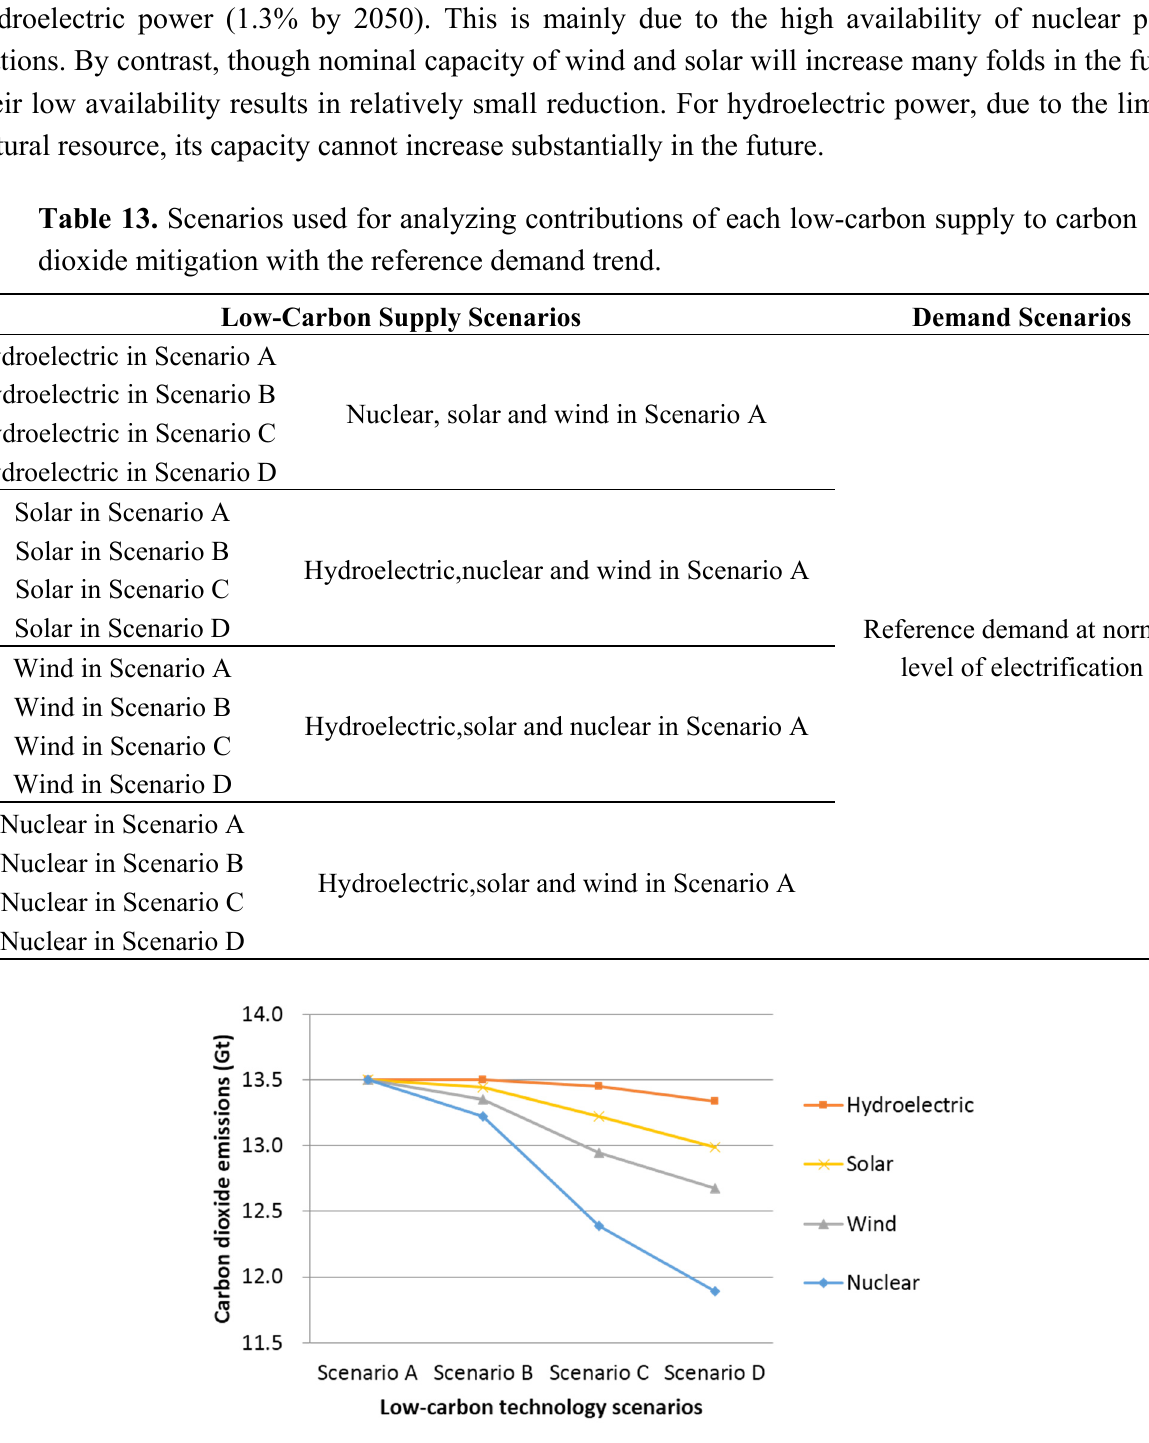
Figure 9. Comparisons of emissions reduction for each low-carbon technology in scenarios by